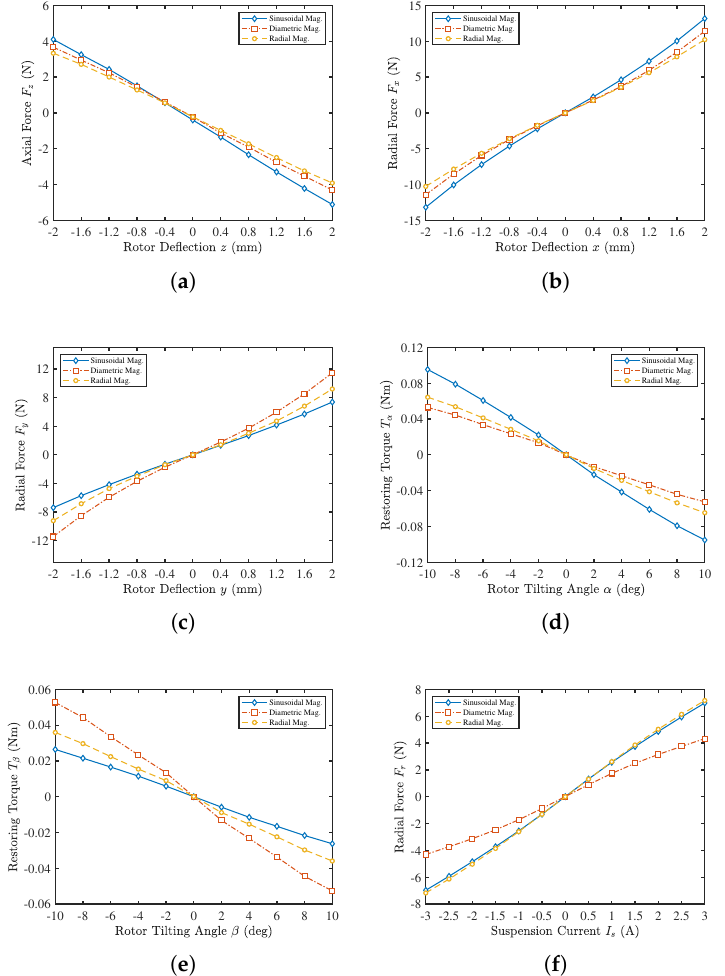
Figure 4. Three-dimensional FEM simulation results for rotors with different magnetization methods. ( a ) Axial reluctance force for a rotor deflection in the z -direction. ( b ) Radial destabilizing force for a rotor deflection in the x -direction. ( c ) Radial destabilizing force for a rotor deflection in the y -direction. ( d ) Restoring torque for a rotor tilting around the axis perpendicular to the direction of magnetization. ( e ) Restoring torque for a rotor tilting around the axis of the magnetization direction. ( f ) Active radial force for an applied suspension current.